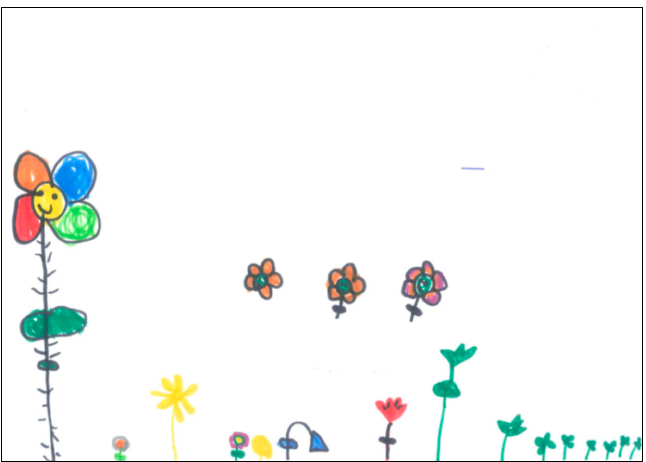
Figure A2. The drawing on the topic of plant that the same child indicated in Figure A1, completed in 2021.